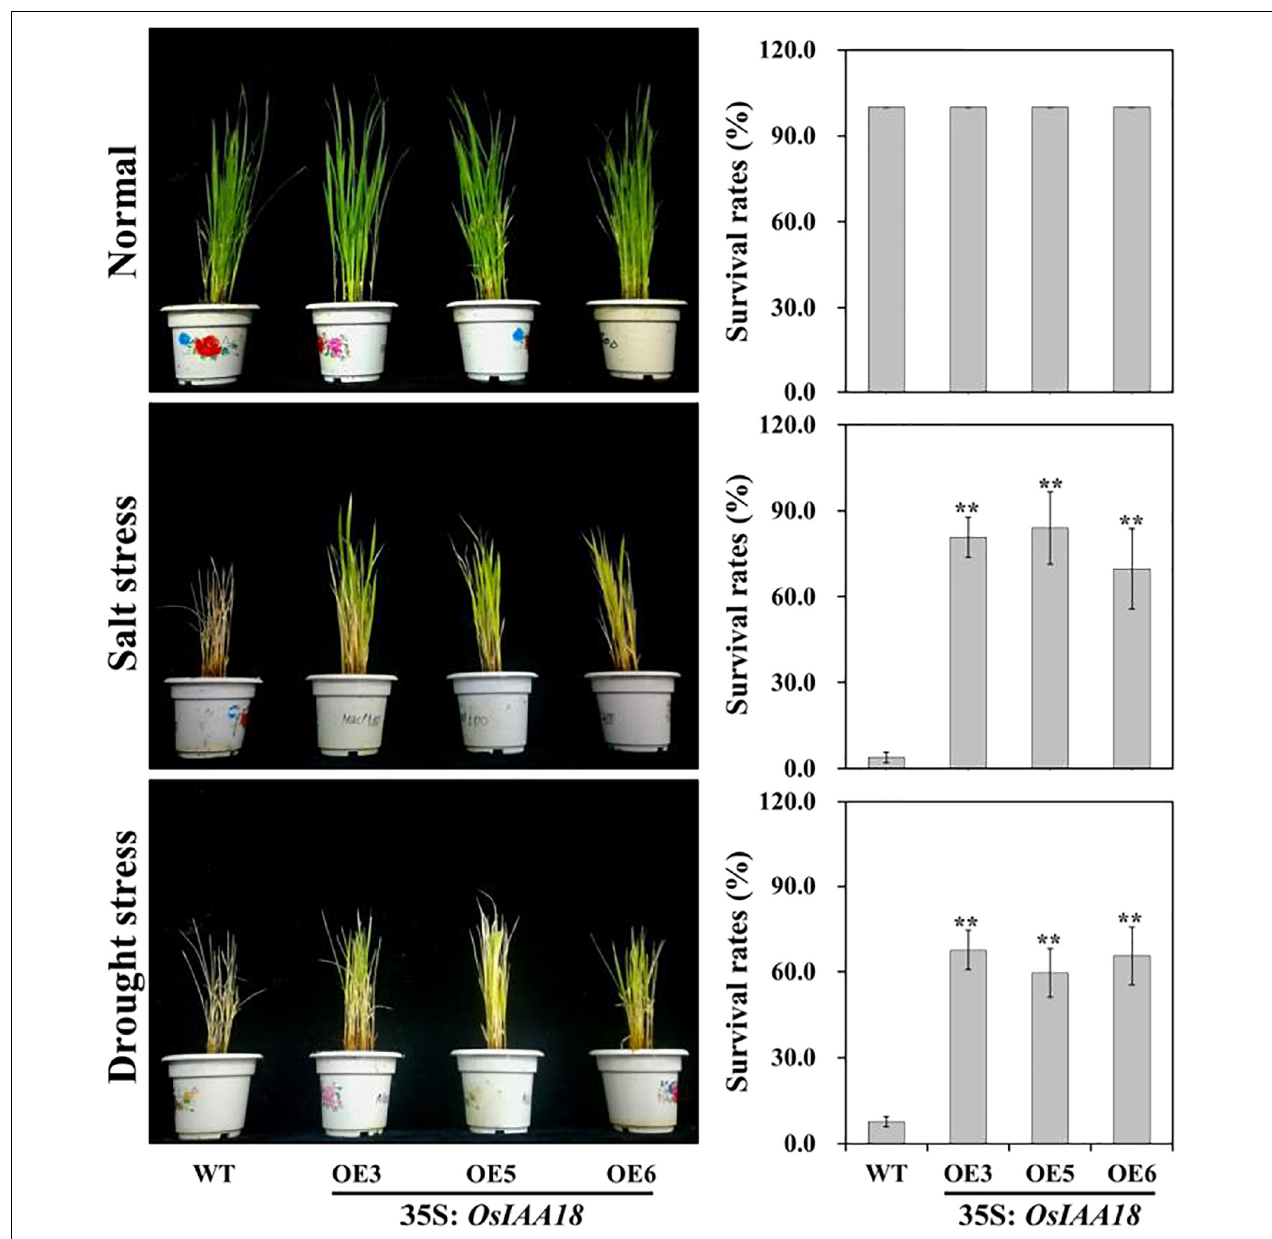
FIGURE 3 | Responses of the transgenic rice plants and WT grown in pots under salt and drought stresses. Transgenic plants and WT were grown in pots and incubated for 2 weeks under normal conditions, for 2 weeks under 200 mM NaCl stress, and for 2 weeks by stopping irrigation and recovery with rewatering for 2 weeks. Survival rates of overexpressing OsIAA18 and WT plants after salt and drought stresses were examined. Data are presented as means ± SE ( n = 3). The values of * and ** indicate a significant difference from that of WT at P < 0.05 and < 0.01, respectively, by Student’s t